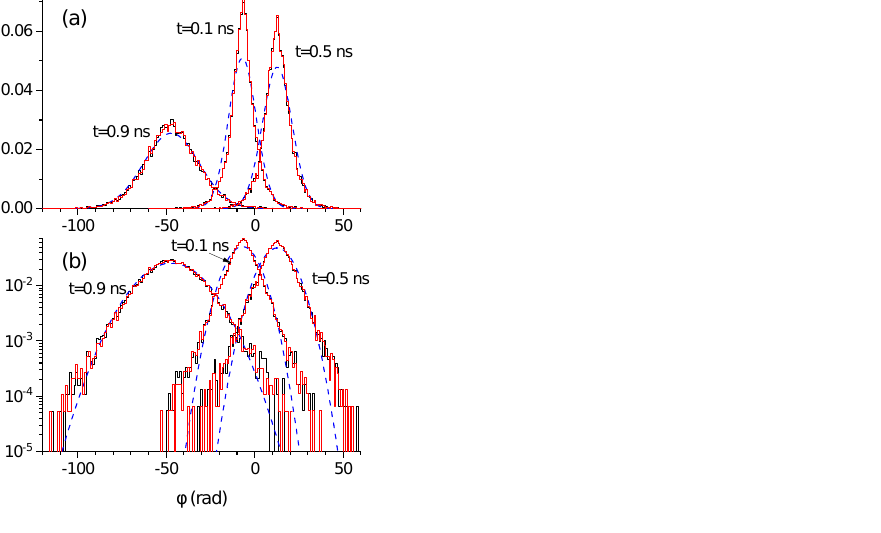
Figure 3. Probability density function of the phase at three different times in ( a ) linear, and ( b ) logarithmic vertical scale. Pdfs obtained with and without noise in the carrier number equa- tion are plotted with red and black solid lines. Gaussian approximations are plotted with blue dashed lines.